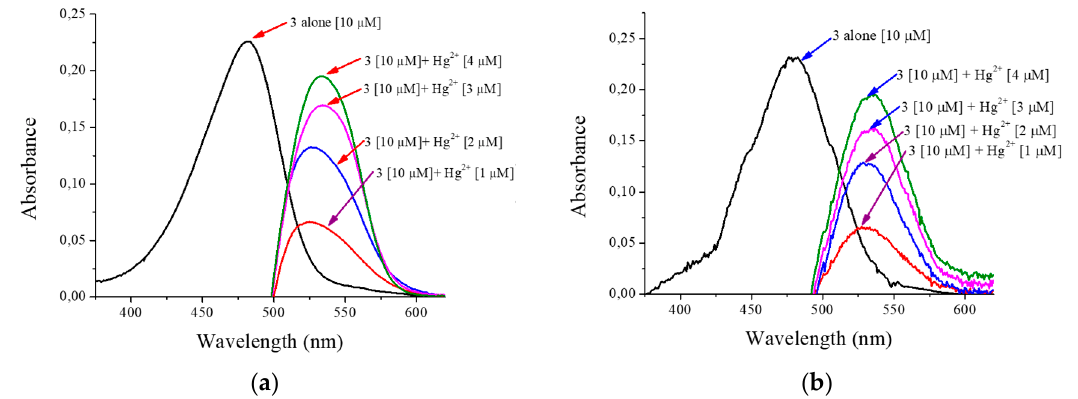
Figure 11. Absorbance the compound 3 and response in front mercuric ions: ( a ) spectrophotometer